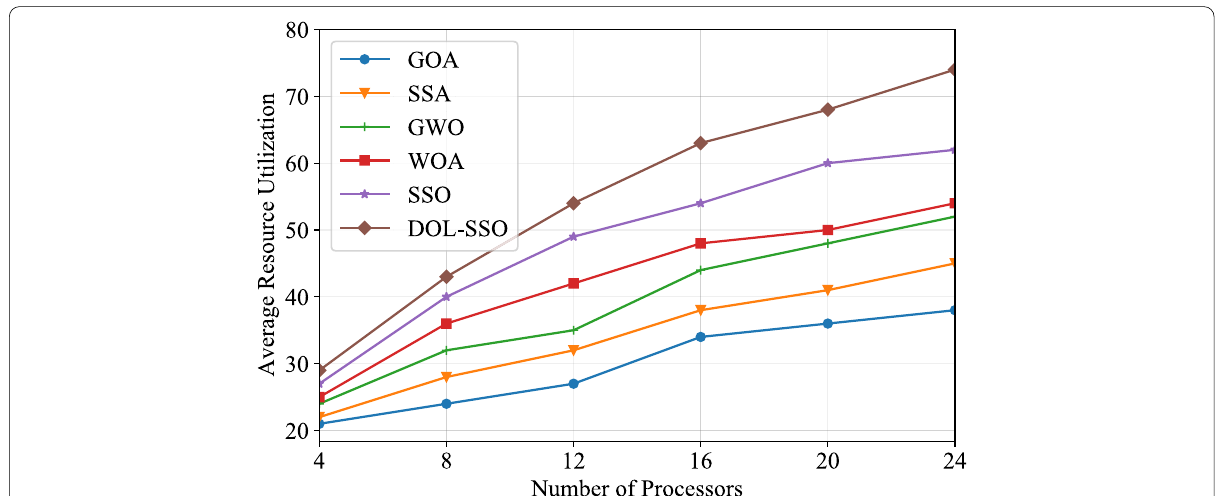
Fig. 3 Resource Consumption concerning the number of